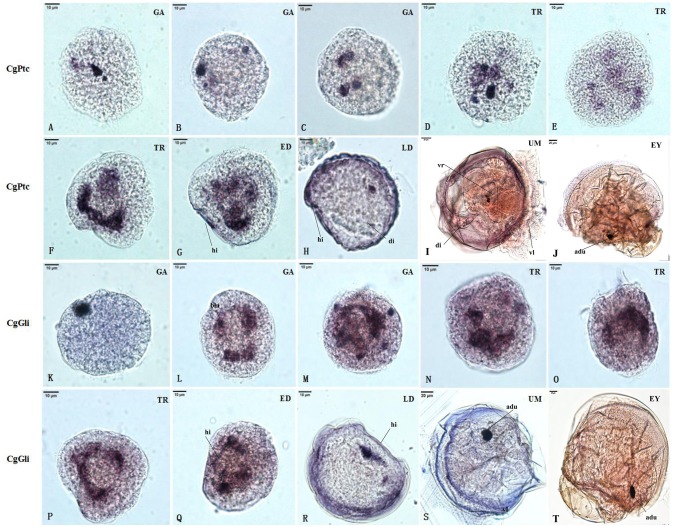
RNA localization patterns of key hedgehog pathway genes during embryonic to larval stage. (A–C) RNA localization patterns of CgPtc during gastrula stages. (D–F) RNA localization patterns of CgPtc during trochopore stages. (G) RNA localization pattern of CgPtc during the early D-shaped stage. (H) RNA localization pattern of CgPtc during the late D-shaped stage. (I) RNA localization patterns of CgPtc during umbo stages. (J) RNA localization patterns of CgPtc during eyed stages. (K–M) RNA localization patterns of CgGli during gastrula stages. (N–P) RNA localization patterns of CgGli during trochopore stages. (Q) RNA localization pattern of CgGli during the early D-shaped stage. (R) RNA localization pattern of CgGli during the late D-shaped stage. (S) RNA localization patterns of CgGli during umbo stages. (T) RNA localization patterns of CgGli during eyed stages. GA, gastrulae stage; TR, trochophore stage; ED, early D-shaped stage; LD, late D-shaped stage; UM, umbo larvae stage; EY, eyed-larvae stage; bla, blastopore; hi, hinge; di, digest gland; vl, vlum; um, umbo; fo, foot; adu, adductor.